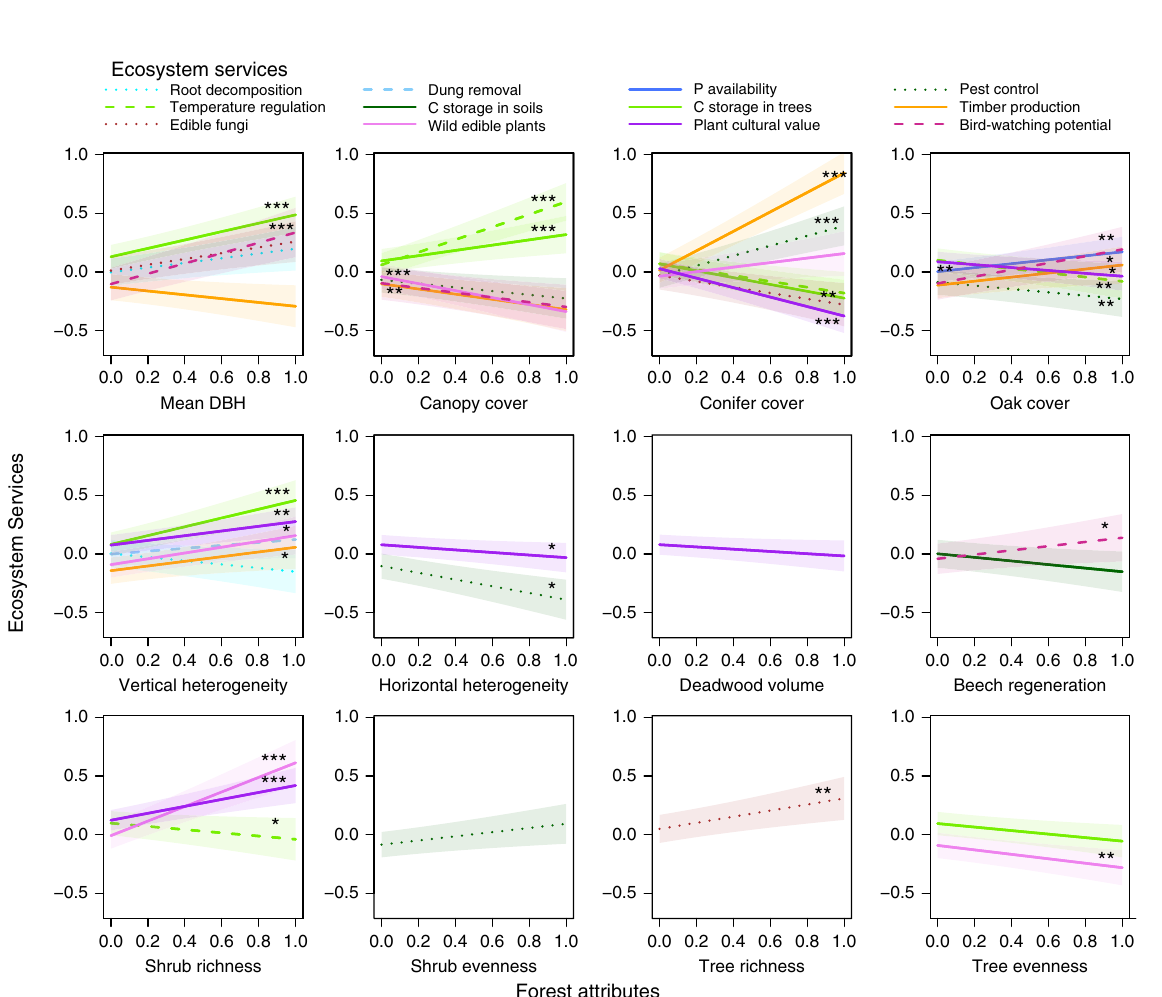
Fig. 4 Effects of forest attributes on ecosystem services. Standardized partial effects from linear models after model simpli fi cation are shown. Shaded lines indicate 95% con fi dence intervals. Asterisks indicate signi fi cant effects also found in the full models (signi fi cance levels: *** p ≤ 0.001; ** p ≤ 0.01; * p ≤ 0.05, as measured by Student ’ s t -test). DBH diameter at breast height. See Supplementary Tables 6 and 8 for details, and Supplementary Data 3